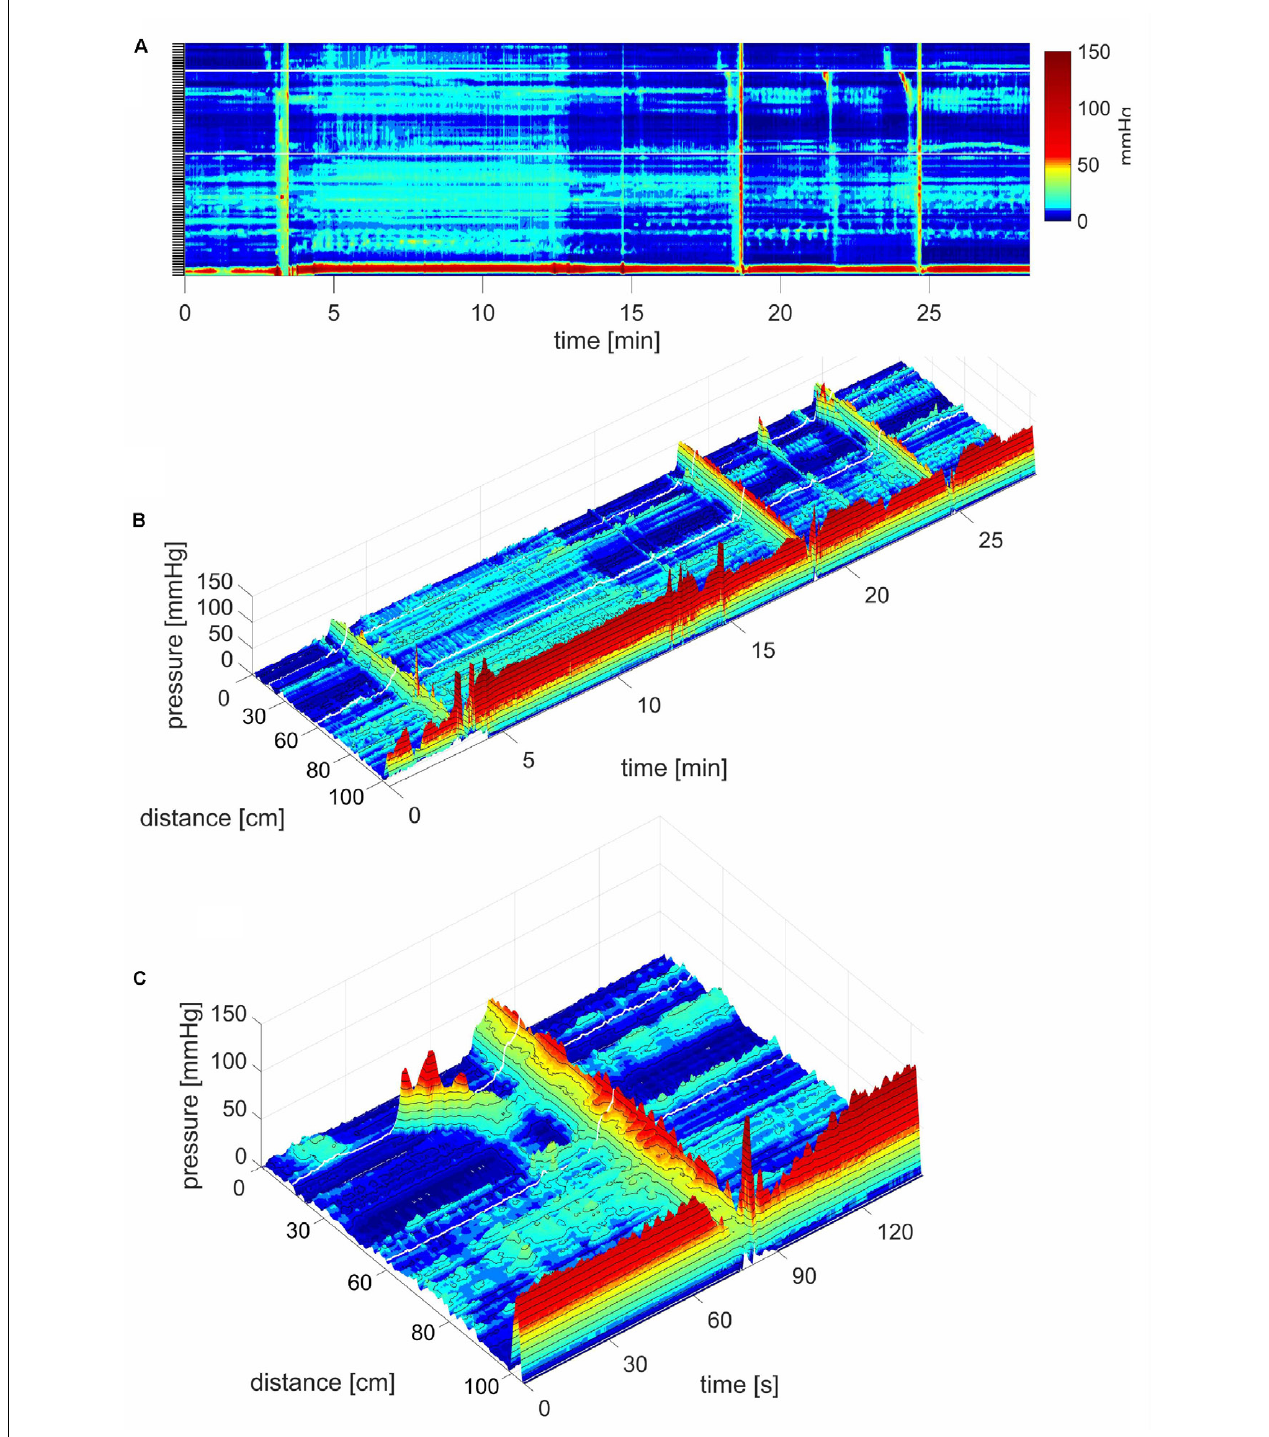
FIGURE 8 | Simultaneous Pressure Waves in response to a meal. (A) SPWs that span the entire colon (102 cm). The lighter area, between ∼ 4 and 12 min, is the time period where the subject sits up causing an increase in intraluminal pressure, and takes in the meal. In this subject, a meal did not induce HAPWs but relatively high amplitude SPWs associated with liquid expulsion. An SPW appeared just before (anticipating the meal) and two following the meal. Anal sphincter relaxations were part of the SPW activity and the SPWs were consistently preceded by relatively low amplitude proximal propagating pressure waves. In addition, a lot of segmenting activity occurred. No pressure waves appeared in the time period between the end of balloon distention and the start of meal intake which was 20 min, except for the one just 1 min before meal intake. All three SPWs were associated with liquid outflow. (B) A 3D rendition of (A) . (C) 3D image of an SPW.